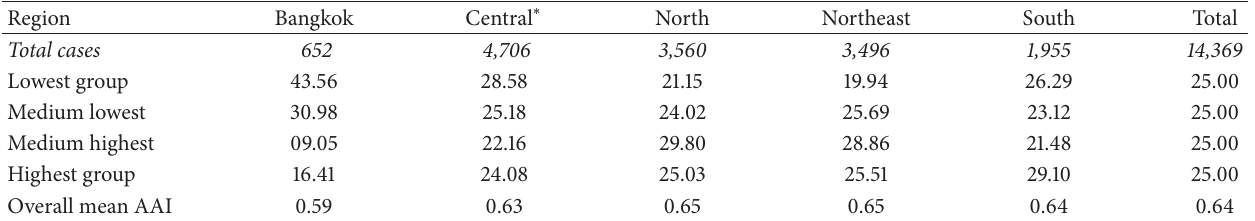
Table 5: Distribution of female older persons according to quartiles of mean active ageing level and region.